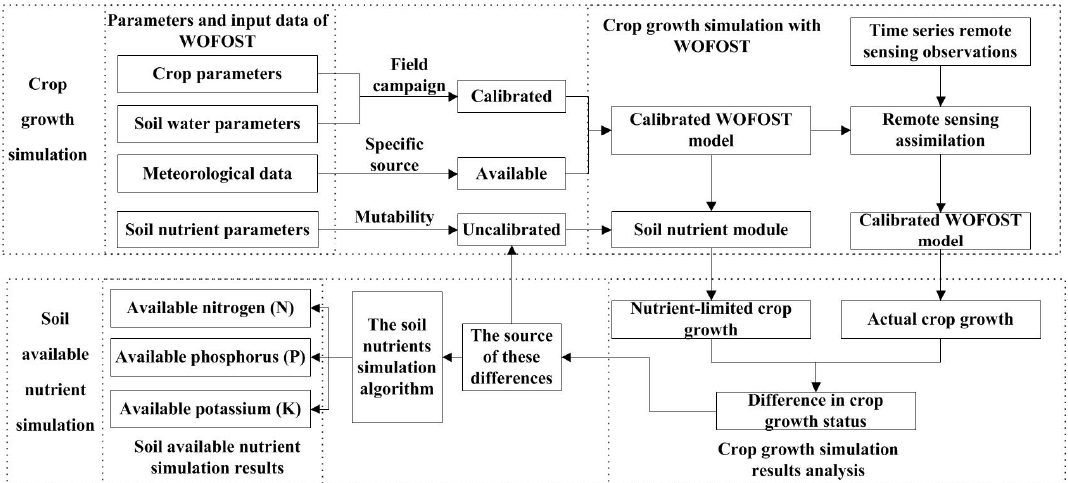
Figure 3. The process of soil nutrient estimation.